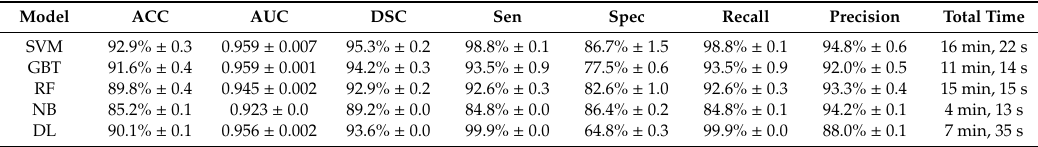
Table 5. Four-fold cross-validation performance